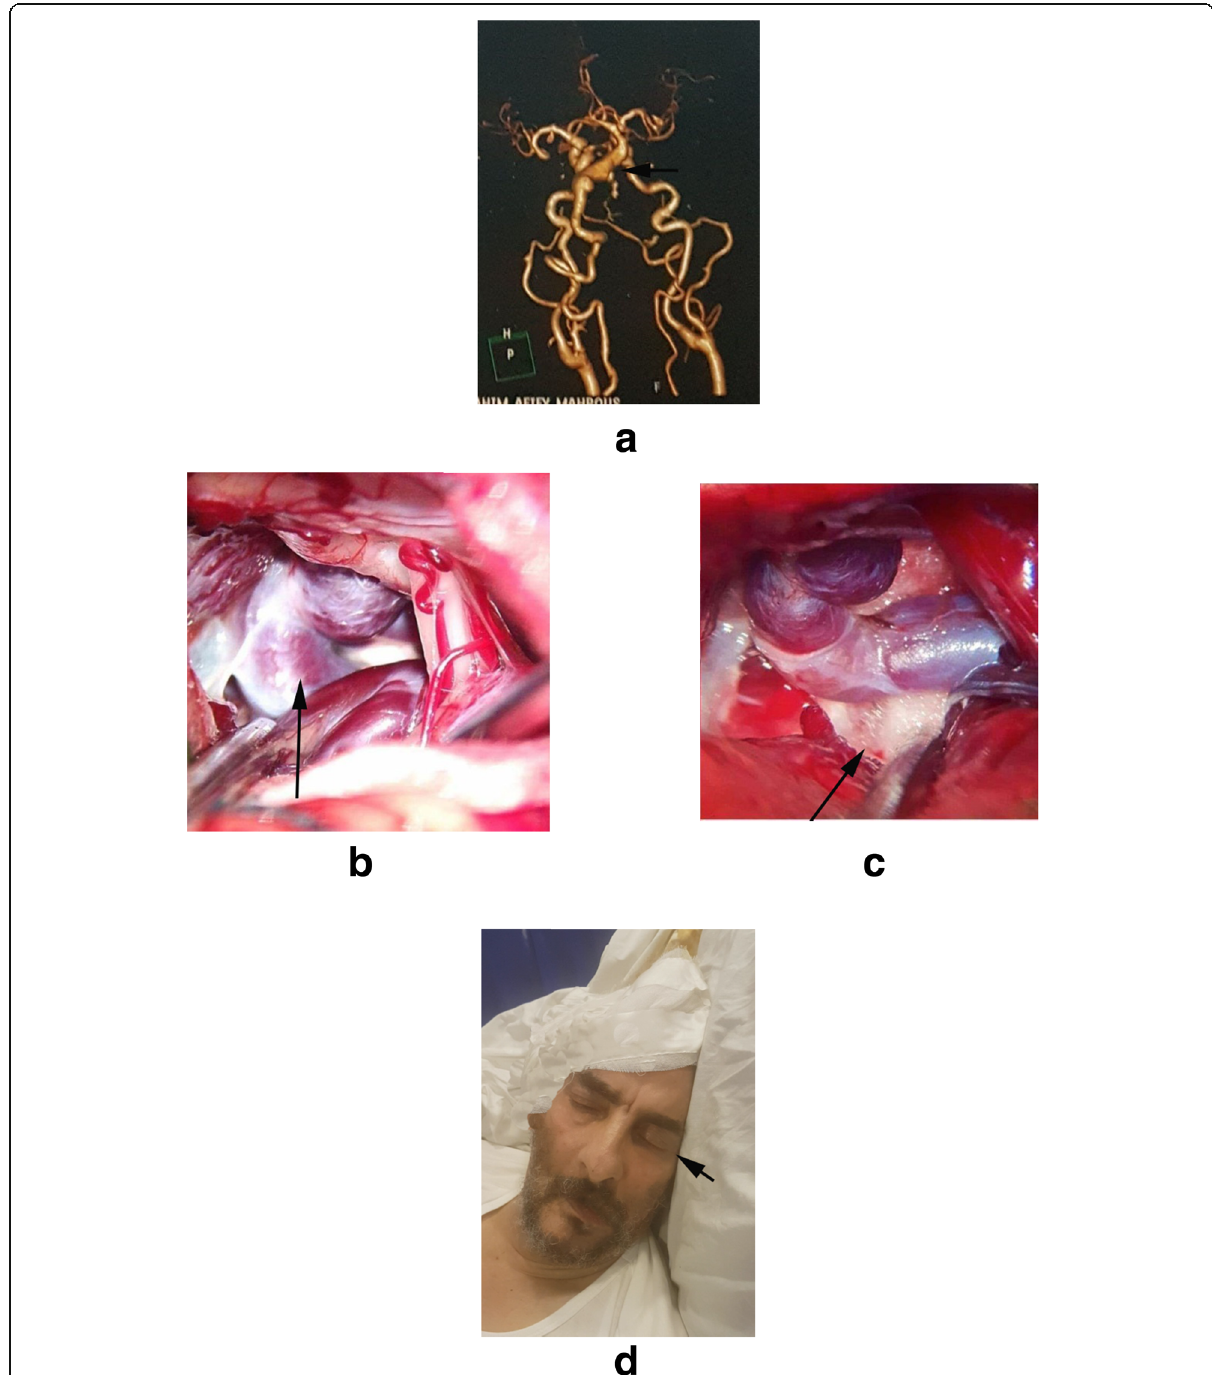
Fig. 3 A case of hemifacial spasm treated surgically with microvascular decompression. a MRA showing dolicoectatic vertebral artery. b Intraoperative view showing ectatic vessel compressing root entry zone via retrosigmoid approach. c Intraoperative view after mobilization of the vessel with Teflon placement to maintain new position. d Early postoperative view showing improvement in